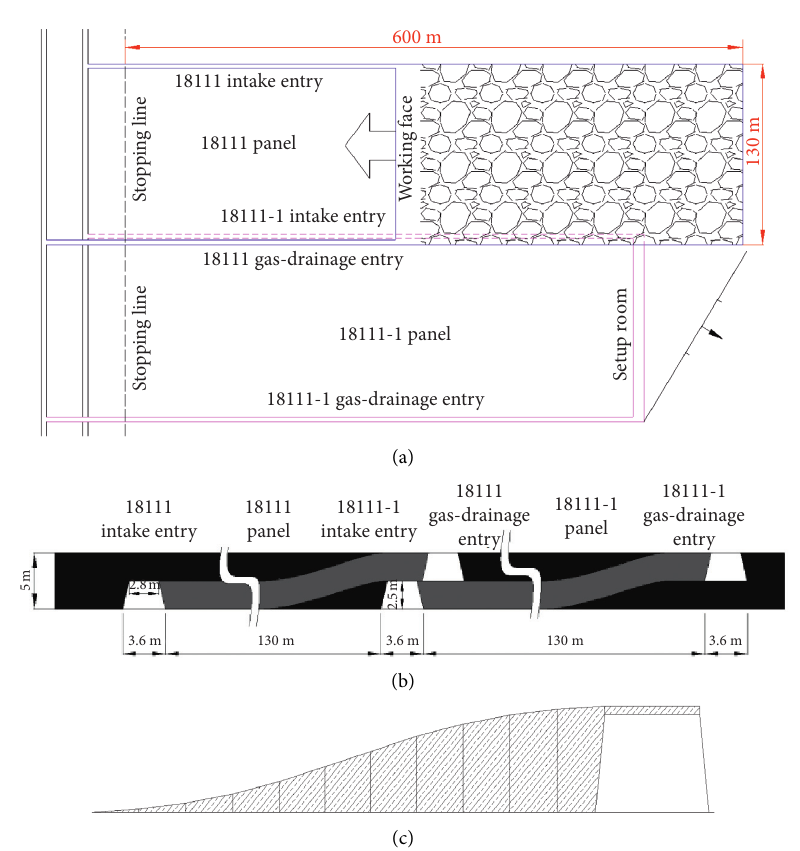
Figure 22: Panel layout of SLL and transition part in Zhenchengdi coal mine: (a) plane view; (b) section view; (c) transition part (elevating part)